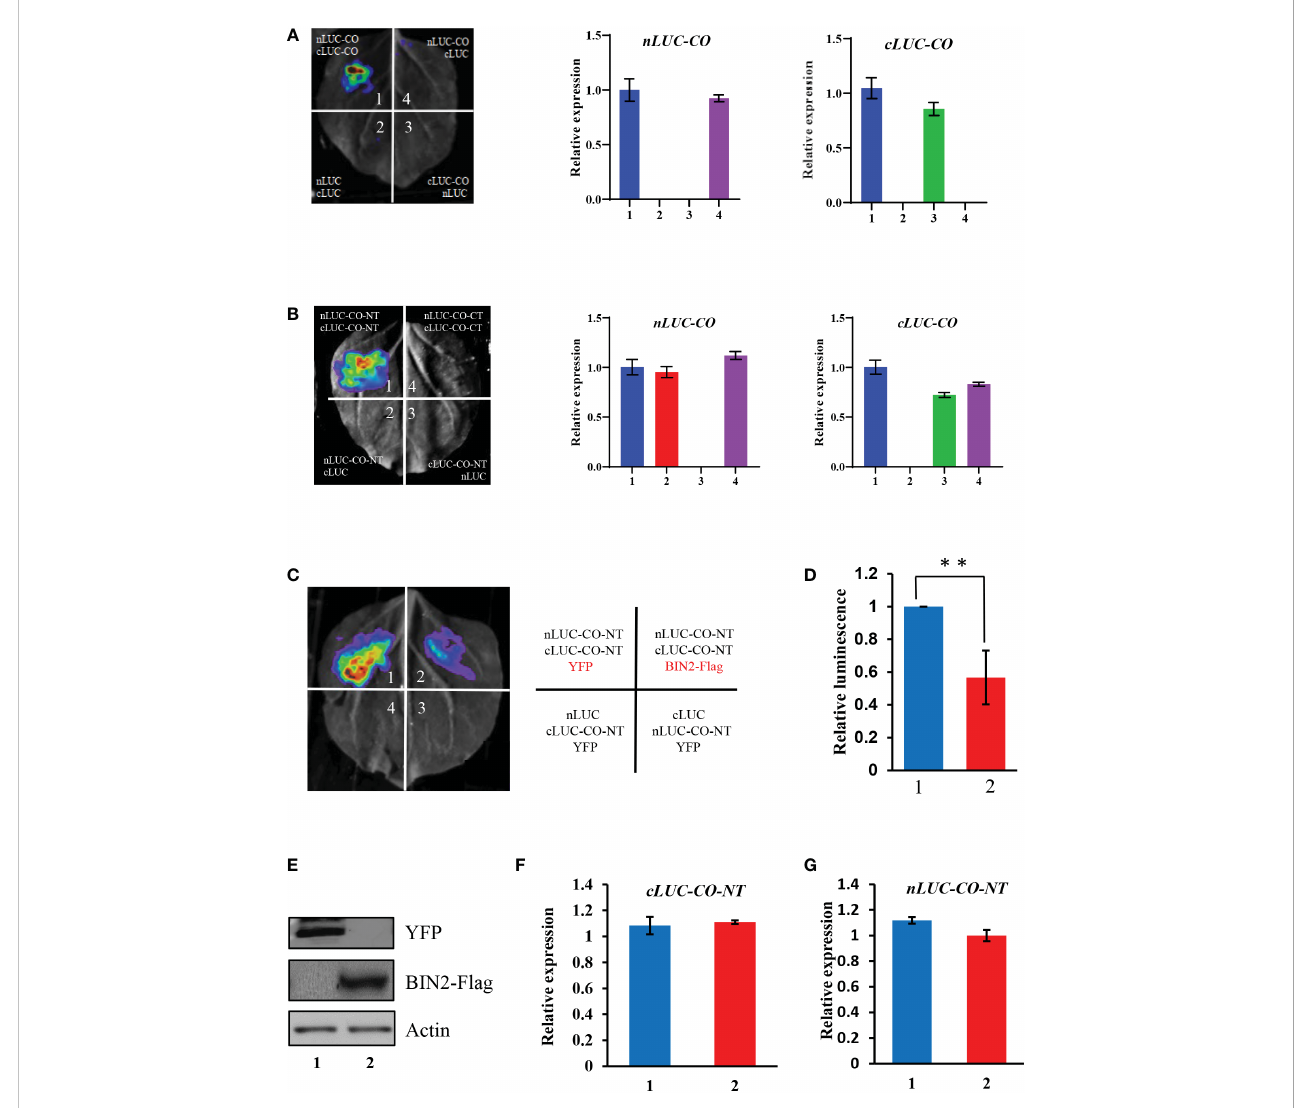
FIGURE 5 BIN2 represses CO-CO interaction. (A) LCI assays showing the interaction of CO-CO. The expression levels of nLUC-CO and cLUC-CO in the in fi ltrated N. benthamiana leaf areas were determined by qRT-PCR. Results were normalized to NbACTIN1 ( NbACT1 ). (B) LCI assays showing that the N-terminal part of CO mediates the interaction of CO-CO. The expression levels of nLUC-CO and cLUC-CO in the in fi ltrated N. benthamiana leaf areas were determined by qRT-PCR. Results were normalized to NbACTIN1 ( NbACT1 ). (C, D) LCI assays showing that BIN2 could inhibit the interaction of CO-CO. YFP was used as a control instead of BIN2-Flag. A representative image was shown in (c) , and the quanti fi cation of relative luminescence intensities was conducted in (d) . Data are means ± SD. Asterisks indicate a signi fi cant difference according to Student ’ s t test (**, P < 0.01). (E) Areas (in fi ltrations 1 and 2) were determined by immunoblotting. Actin was used as a loading control. (F, G) The transcript levels of nLUC-CO (f) and cLUC-CO (g) in the in fi ltrated N. benthamiana leaf areas (in fi ltrations 1 and 2) were quanti fi ed by qRT-PCR (means ± SD). Results were normalized to NbACTIN1.